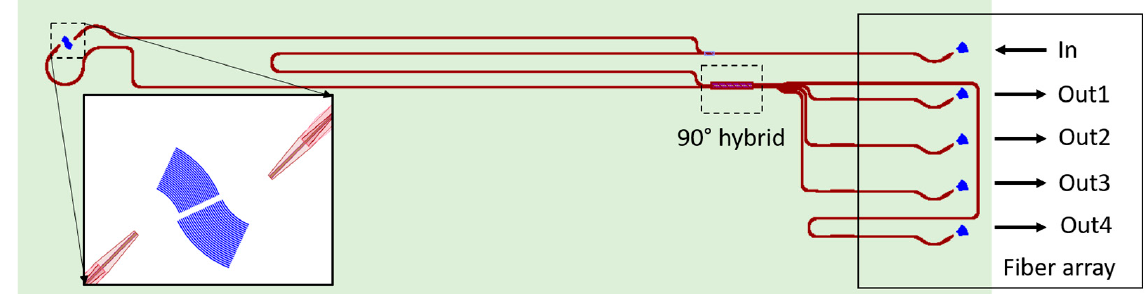
Figure 6. Schematic of the homodyne LDV design with an external laser source and PDs. This is a redraw of the system shown in Ref. [34].